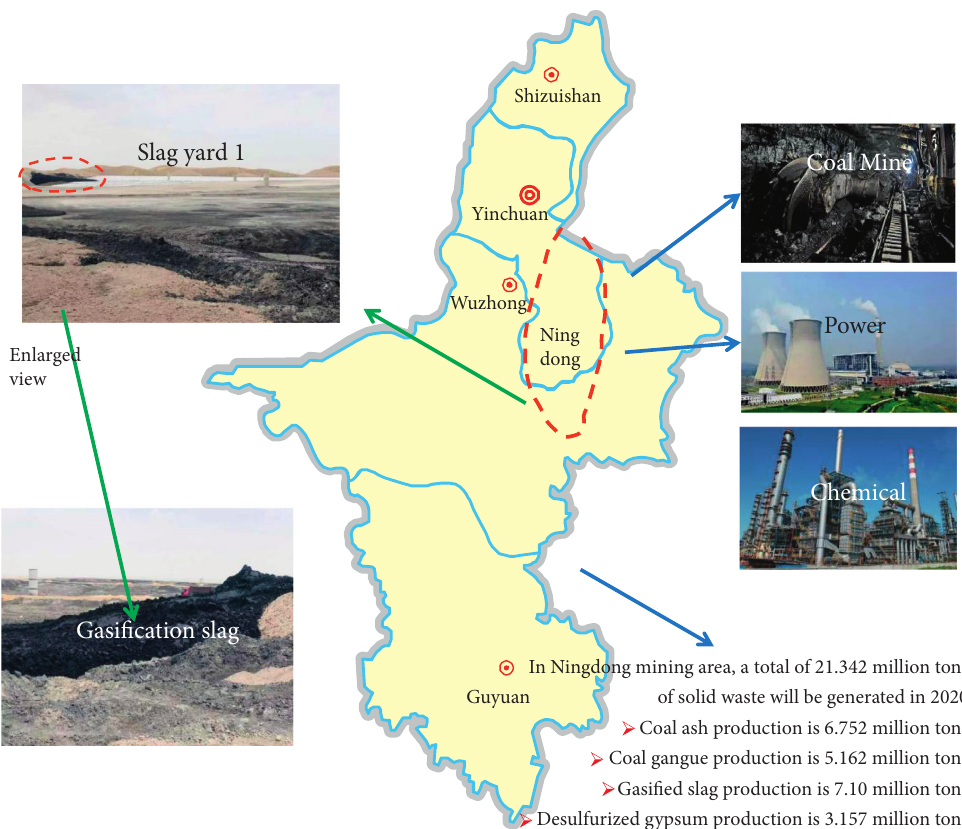
Figure 1: Analysis of coal-based solid waste output in the Ningdong mining